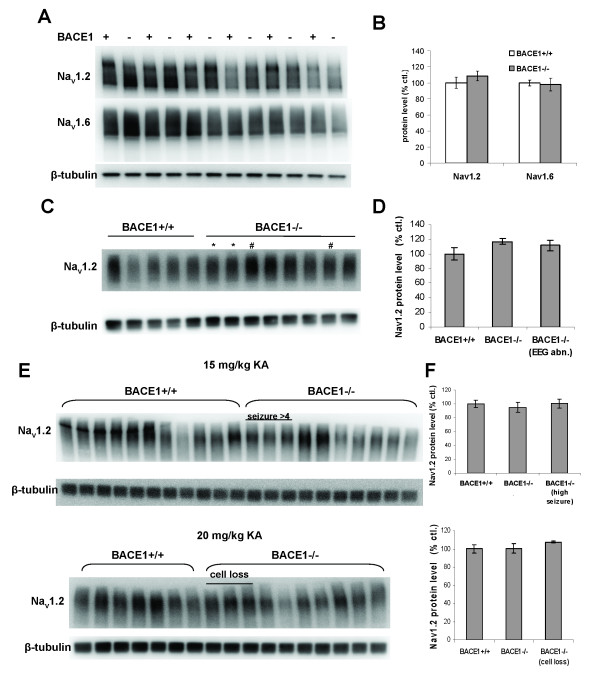
No change in sodium channel total protein levels in BACE1-/- mouse brain. Whole brain or hippocampal homogenates from BACE1-/- mice and wild-type littermate controls were resolved by SDS-PAGE for Western analysis with antibodies against Nav1.2 and Nav1.6. Samples in A and B are whole brain homogenates from naïve animals; Samples in C and D are hippocampal homogenates from mice subjected to EEG recordings; Samples in E and F are whole brain homogenates from mice injected with 15 mg/kg (top) or 20 mg/kg (bottom) KA. Panels B, D and F are quantifications of sodium channel signals performed on the blots in panels A, C and E, respectively. No significant differences were detected in any comparison. All measures were normalized using β-tubulin signal. Error bars indicate SEM. In C, * indicates mice that exhibited spontaneous seizures and # indicates mice that exhibited abnormal background/spiking on EEG. In E, mice with seizure >4 (high seizure) and cell loss are indicated.